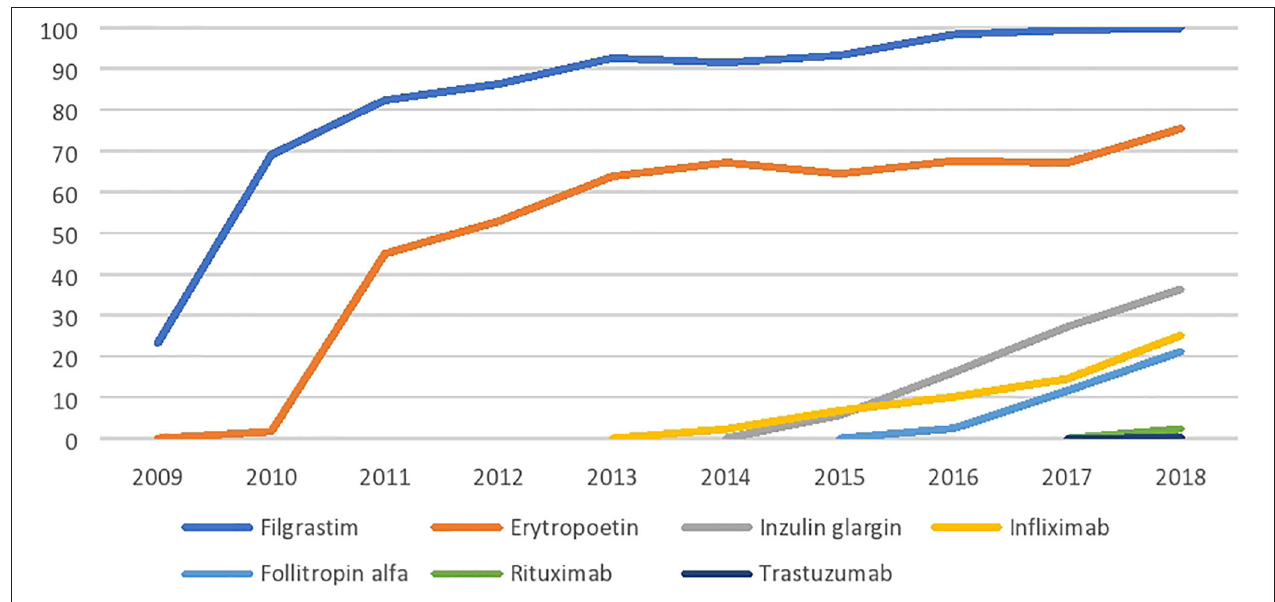
FIGURE 1 | Biosimilar penetration in Slovakia